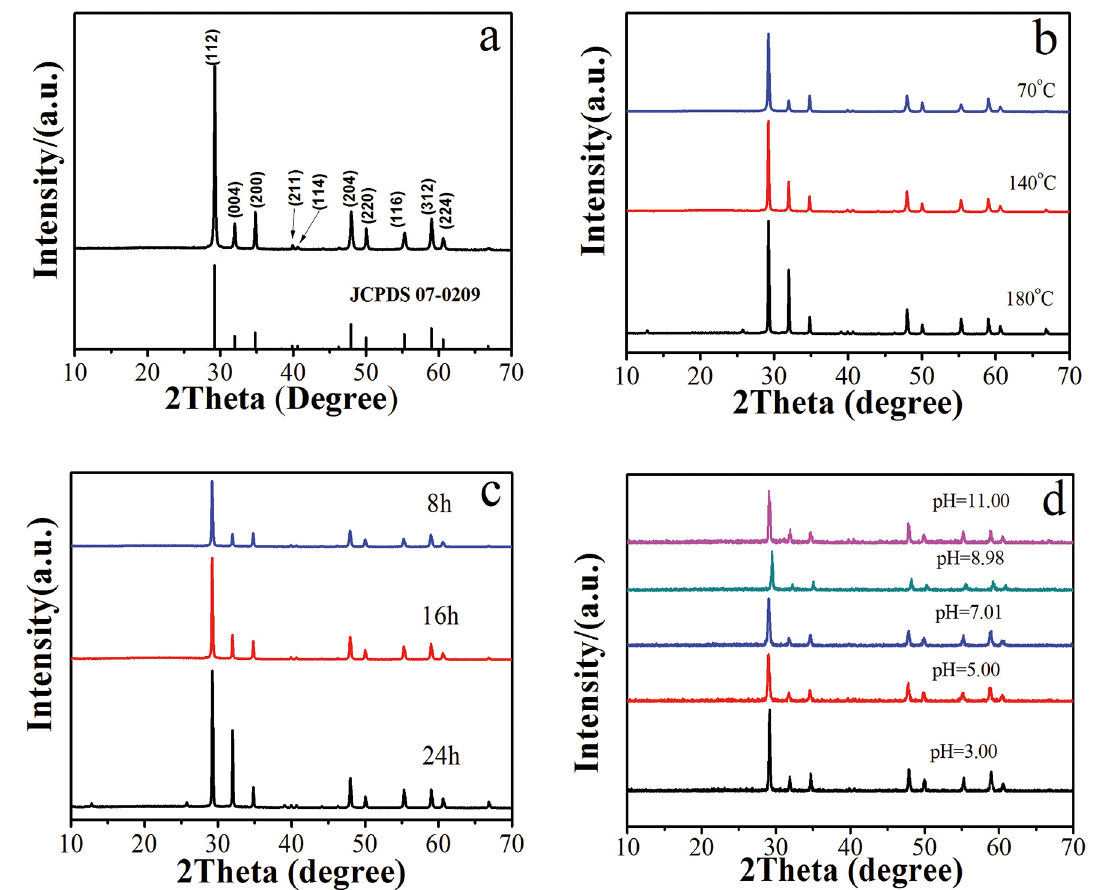
products. (a) JCPDS 07-0209, (b) temperature series at pH=5 for 24 h, (c) time series 4